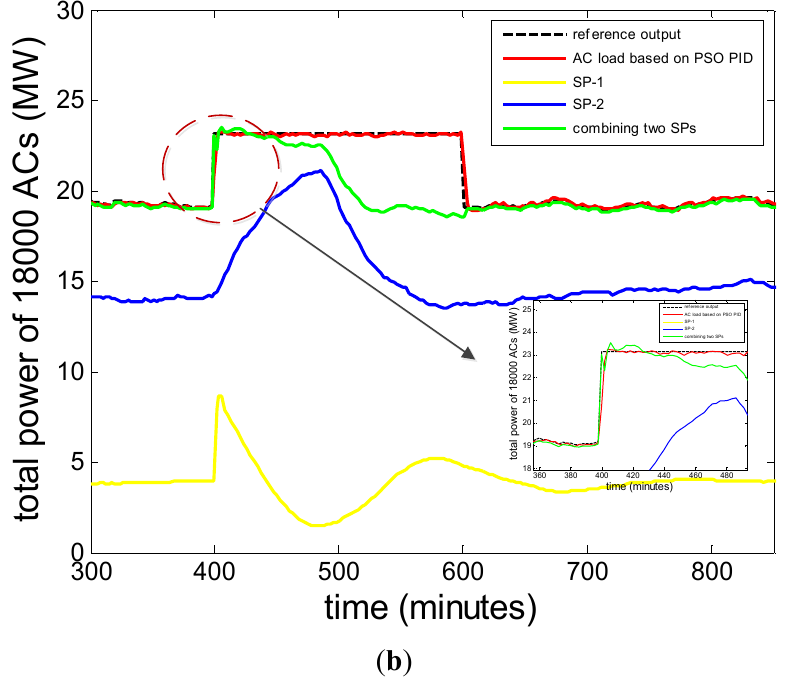
Figure 17. A comparison of power demand response between the proposed closed loop strategy and hybrid SP protocol combining SP-1 and SP-2. ( a ) Negative pulse: p = 0.2, ξ = 0.5 °C; ( b ) Positive pulse: p = 0.2, ξ = − 0.5 °C